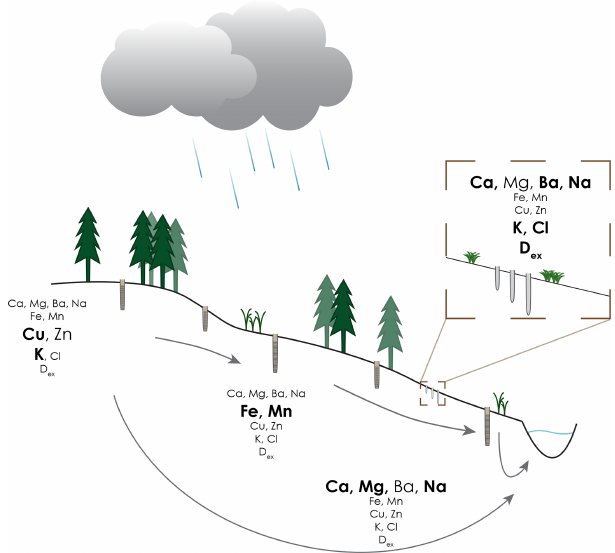
Figure 2. Illustration of a hillslope cross section with different (ground-)water compartments (based on Kiewiet et al., 2019 and Ta- ble 2), showing the tracers used in combination with δ 2 H and δ 18 O to characterise the different source areas. For most elements, the concentrations were low in rainfall compared to the concentrations in the other water compartments. High potassium, barium and chlo- ride concentrations and high deuterium excess (D ex ) are indicative of soil water. For shallow groundwater, the concentrations of copper and potassium were higher at (forested) ridge locations, whereas for sites with water tables that are persistently close to the surface, the concentrations of iron and manganese were higher. We assume that higher concentrations of geogenic solutes (calcium, magnesium and sodium) indicate longer subsurface residence times. The isotopic composition for the different water compartments depends on the composition of recent